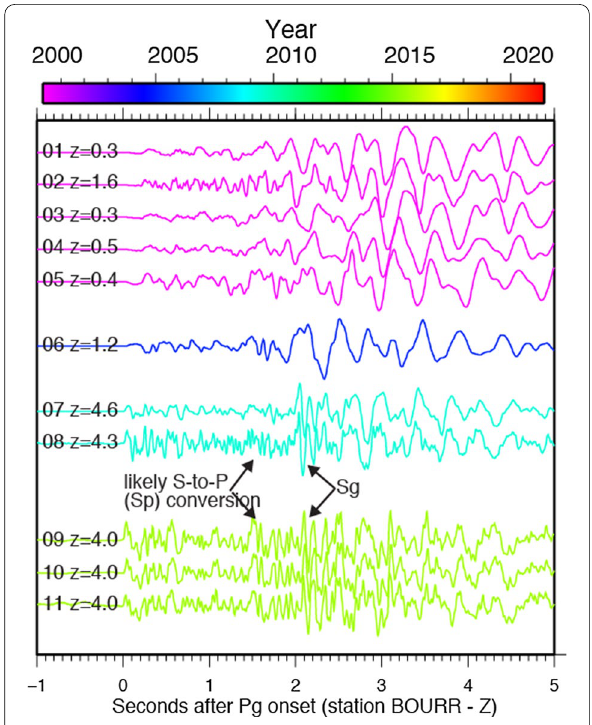
Fig. 8 Vertical-component waveforms of selected earthquakes in the the Saint-Ursanne region recorded at station BOURR. Z is the focal depth in kilometers resulting from the relative relocations shown in Fig. 5. Colors denote origin time. Note the differences in waveform characteristics between near-surface sources (event 1–6, including the sequence of 2000) and sources likely located in the Paleozoic crystalline basement (event 7–11). See text for